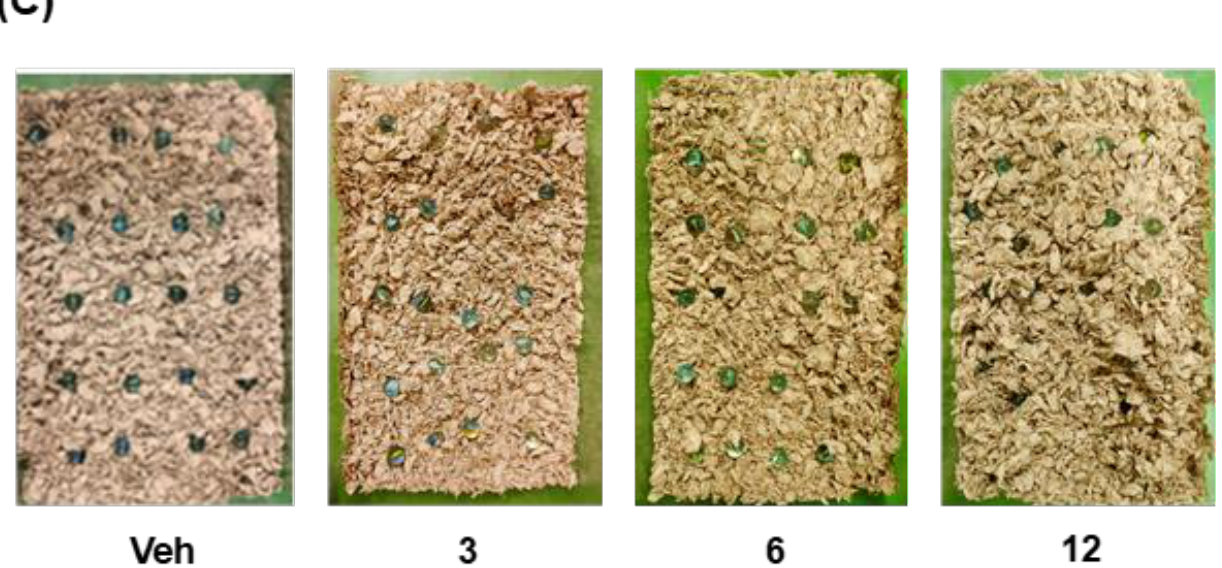
Figure 3. Effect of D5 exposure on repetitive activity in offspring mice: ( A ) bar graph of self-grooming time in the grooming test; ( B ) bar graph of buried marble number in the marble-burying test. ( C ) Representative pictures of the marble-burying test. Significance was obtained using an ANOVA test. ** p < 0.01, *** p < 0.001 and **** p < 0.0001 vs. vehicle. Each value is expressed as the means ± SEM. Vehicle ( n = 20), D5 3 mg/kg/day ( n = 14), D5 6 mg/kg/day ( n = 33), and